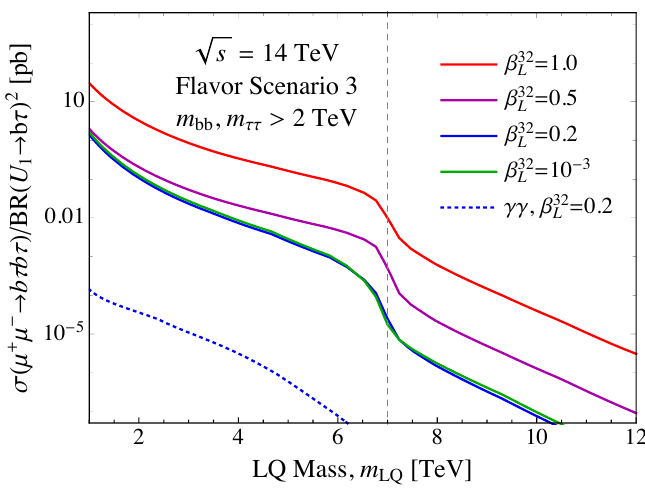
√ Figure 4 . Plot of the PP cross section at s = 14 TeV as a function of the LQ mass for several values of β 32 , normalized by the branching ratio of the LQ. The solid curves show the direct µ + µ − L cross section while the dashed curve shows the VBF-induced process computed using the effective photon approximation (see the diagrams on the bottom row of figure 1). The dashed gray line √ . 0 . 2 the production cross section is dominated indicates the s/ 2 threshold. For couplings β 32 L by the electroweak production for all different